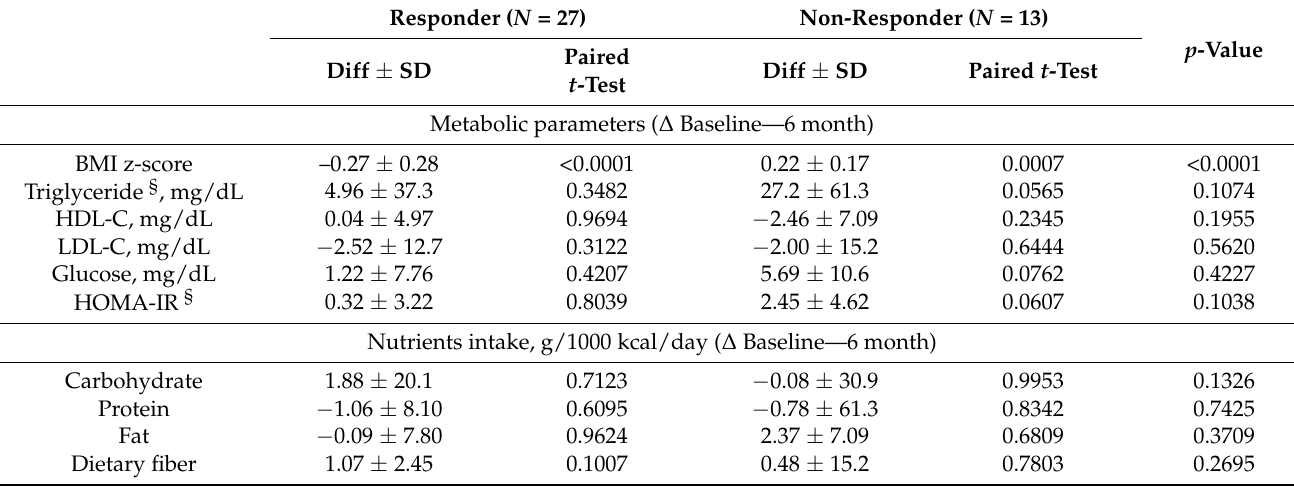
Table 1. Changes in metabolic parameters in responses to the lifestyle